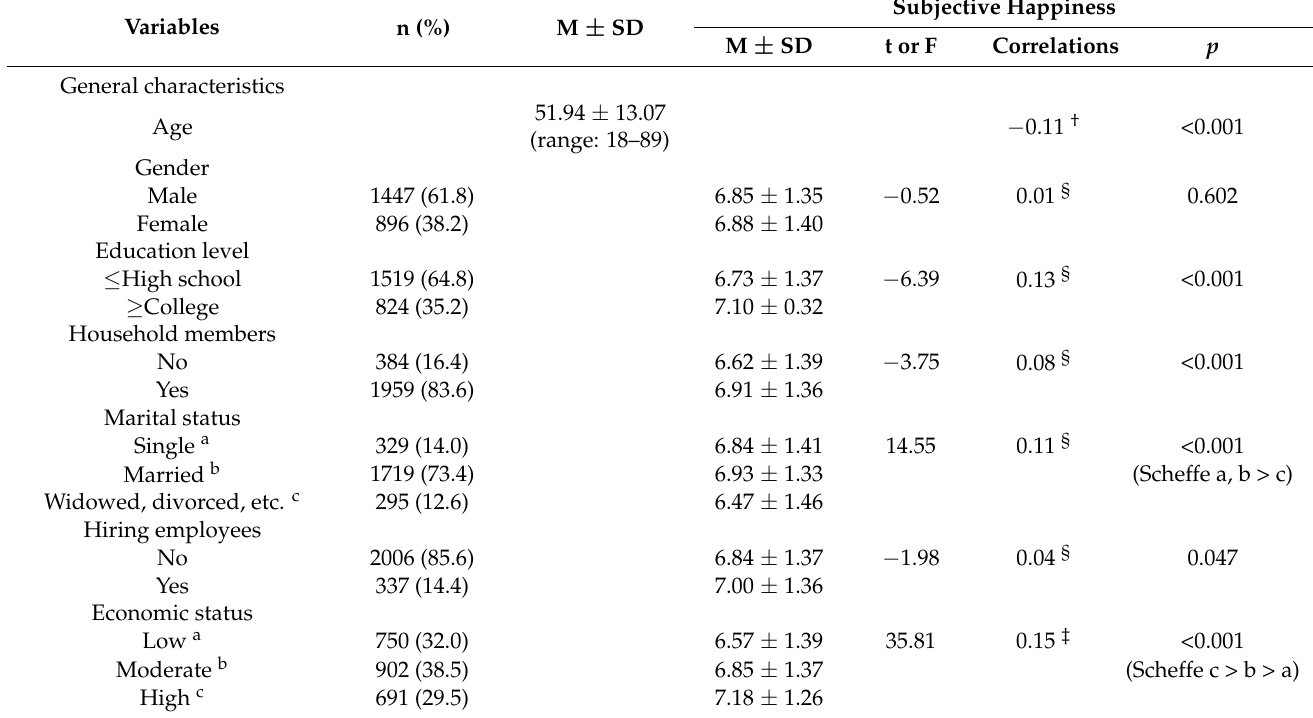
Table 1. Relevance of general characteristics and leisure-related factors for happiness ( N =